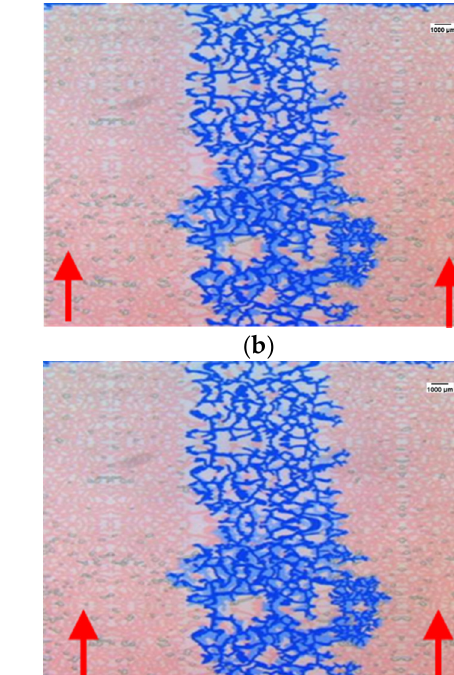
Figure 8. Emulsion water plugging mechanism diagram under the action of the emulsifier: ( a ) the schematic diagram of the emulsion water-plugging mechanism; ( b ) 0 s; ( c ) 100 s; ( d ) 200 s.